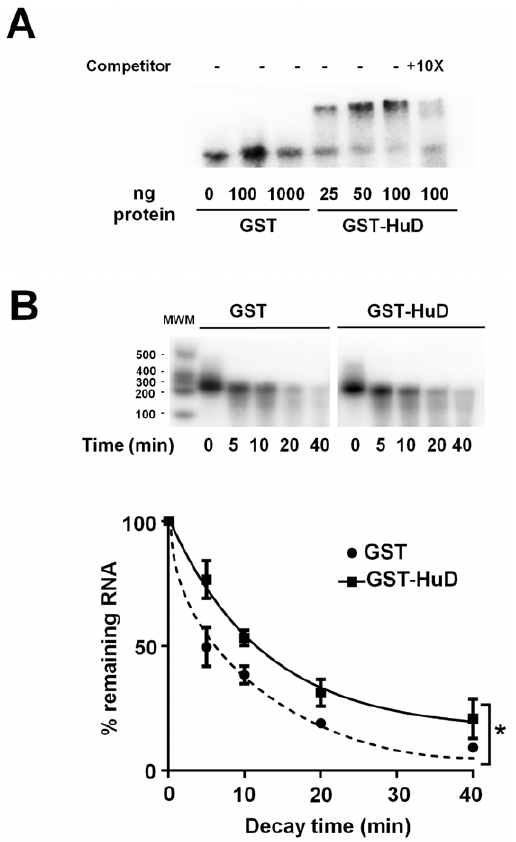
Figure 3. Binding of HuD to the ARE in the BDNF-long 3 9 UTR increases the stability of the mRNA. (A) Specific binding of HuD to the ARE in BDNF-long 3 9 UTR was demonstrated by REMSA using recombinant proteins and radiolabeled RNA along with a 10-fold molar excess of cold ARE competitor. (B) In vitro decay assay of capped and polyadenylated RNA containing the BDNF-ARE with left lane showing RNA molecular weight markers. Analysis of the rate of decay in three independent experiment revealed that the mRNA is stabilized in the presence of HuD. Half-life for GST-treated mRNA is 7.0 6 0.90 min, and for GST-HuD-treated mRNA is 12.0 6 1.0 min. ** indicates p , 0.05 by Two way ANOVA with a quantitative factor (n=3 separate experiments).